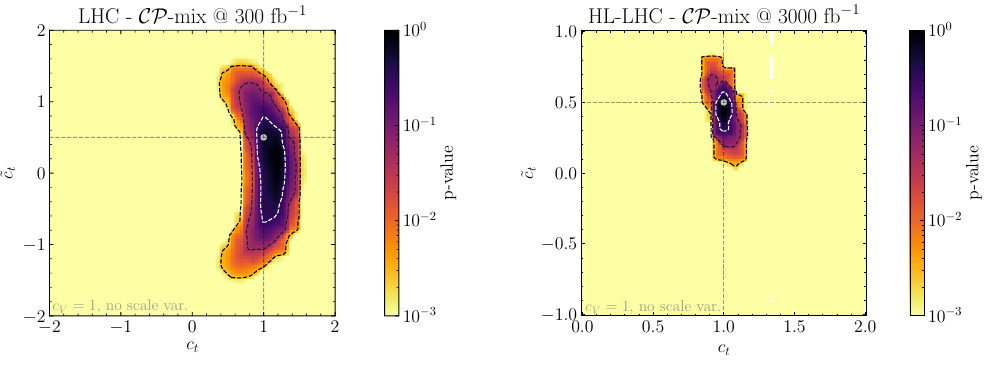
Figure 6 . Observed limit on c t and ˜ c t for a CP -mixed Higgs boson (with c t = 1 and ˜ c t = 0 . 5 ) using a luminosity of 300 fb − 1 (left) and 3000 fb − 1